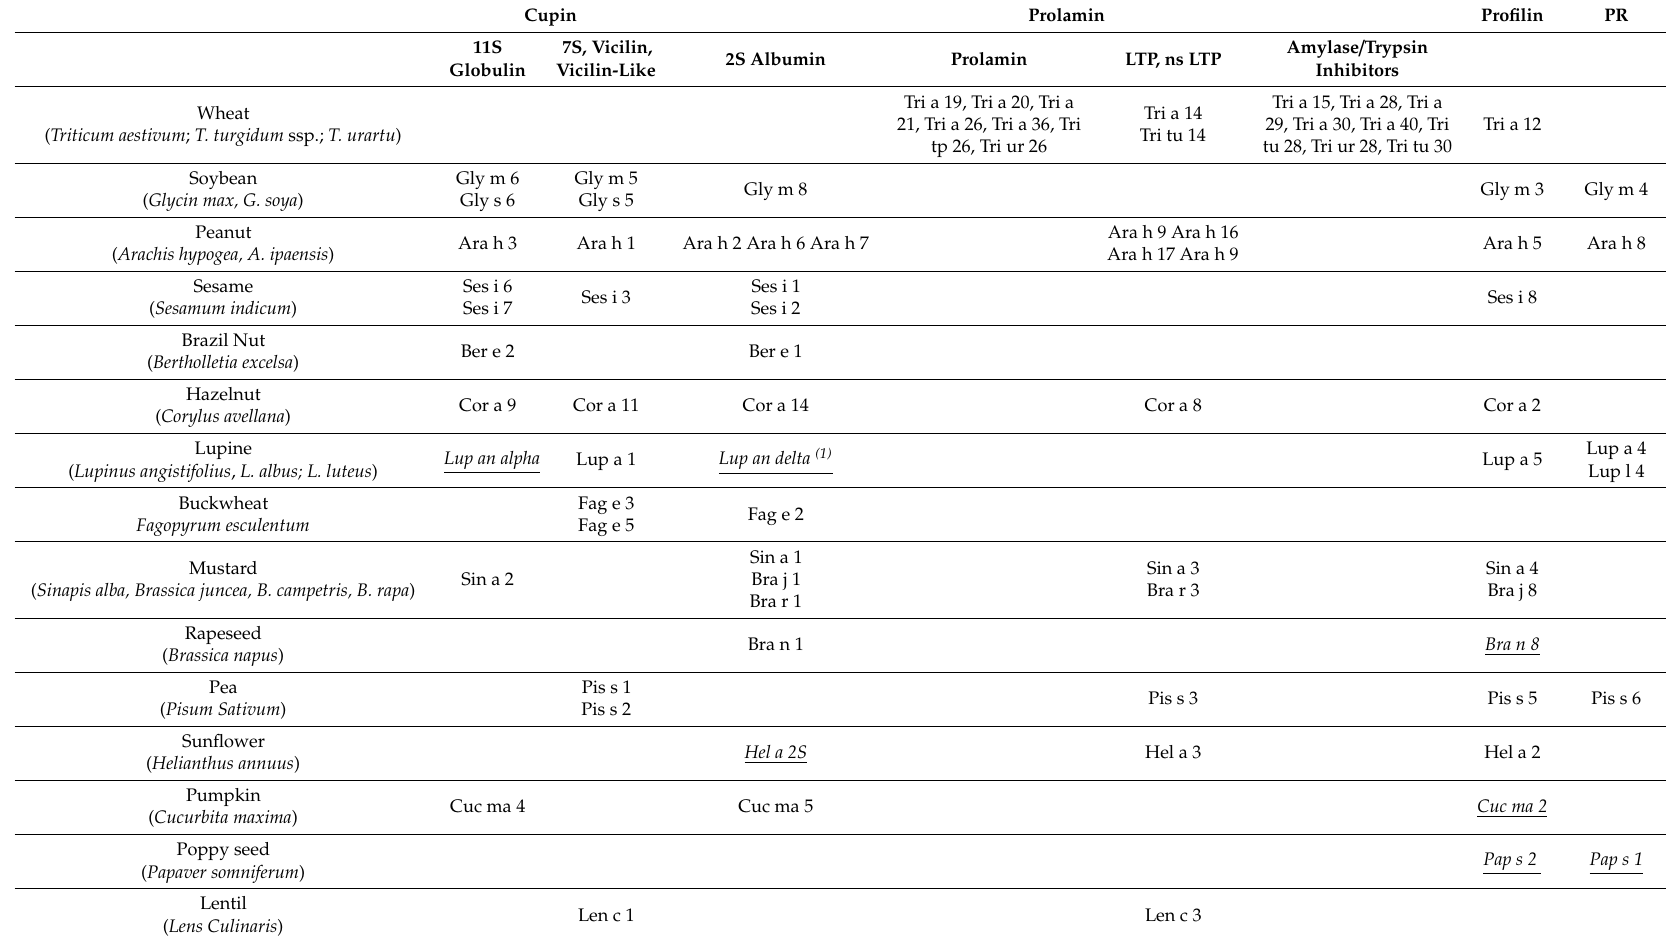
Table 1. List of seed allergens, according to WHO / IUIS allergen nomenclature (http: // www.allergen.org / search.php) and Allergome database (http: // www.allergome. org / script / search_step1.php?clear =